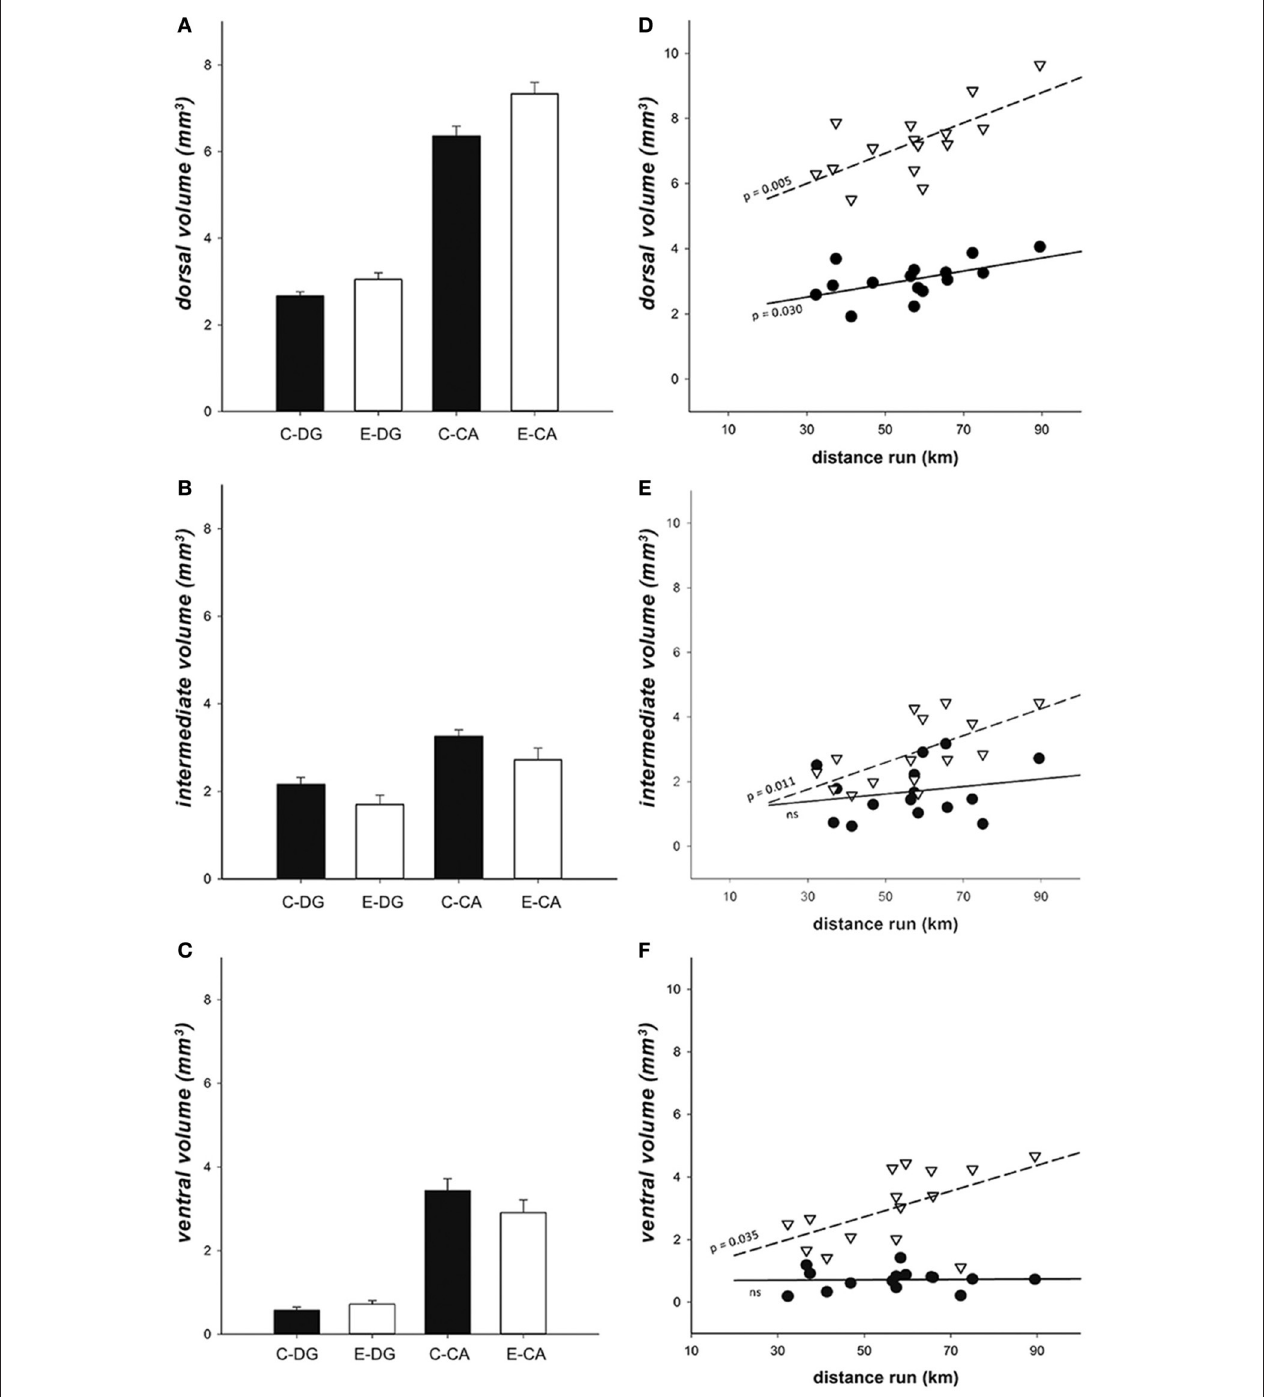
FIGURE 8 | Hippocampal volume. (A–C) Volume comparison showed that enrichment increased dorsal hippocampal volume, but slightly decreased volume of intermediate and ventral hippocampus. Black bars = Controls, white bars = Enriched. (D–F) In enriched animals, individual volume variation in dorsal (D) , intermediate (E) , and ventral (F) CA and DG regions in relation to the distance run. There was a significant interaction between distance run, DG vs. CA, and the three sub-regions [ χ 2 (2) = 84.049, p < 0.001]. Particularly, in dorsal hippocampus (D) both DG ( r 2 = 0.302, p = 0.030) and CA ( r 2 = 0.464, p = 0.005) showed a linear correlation with running. In iHip (E) and in vHip (F) only CA showed a correlation between the distance run and the hippocampal volume (iCA: r 2 = 0.402, p = 0.011; vCA: r 2 = 0.301, p = 0.035). Black dots = DG, white inverted triangles = CA, continuous line = DG regression line, dashed line = CA regression line.